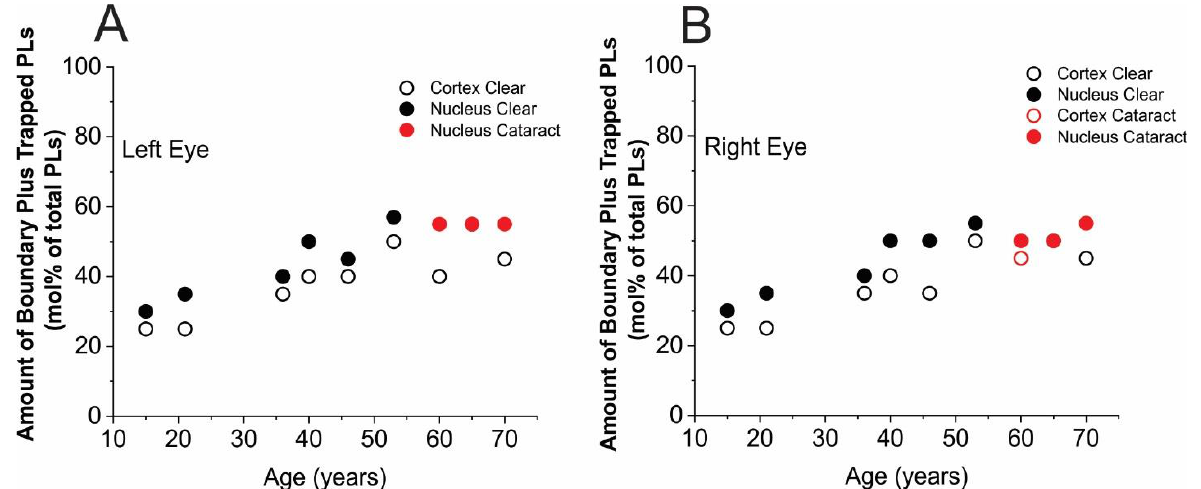
Figure 4. Amounts of boundary plus trapped PLs (mol% of total PLs in domains uniquely formed due to the presence of membrane proteins) in single, intact, human cortical ( ○ ), and nuclear ( ● ) lens membranes. Data obtained from left eye lenses ( A ) and right eye lenses ( B ) are included. Both the left and right eyes of donors aged 60, 65, and 70 years have nuclear cataracts ( ● ) and only the right eye of the 60-year-old donor has a cortical cataract ( ○ ).